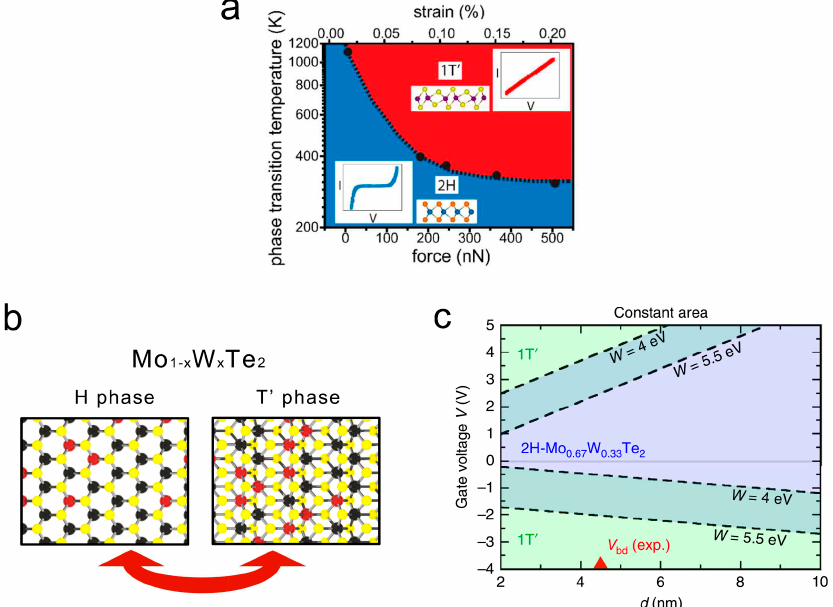
Figure 9. Electron controlled phase transition structure. ( a ) Temperature–force phase diagram for semiconducting 2H and metallic 1T’ MoTe 2 . Reproduced from [107], with the permission of the American Chemical Society. ( b ) Phase structure of WTe 2 . Under the doping of Mo atom, WTe 2 changed from the H phase to T’phase. Reproduced from [115], with the permission of the American Chemical Society. ( c ) Phase boundary at a constant charge in monolayer MoTe 2 and MoS 2 . Reproduced from [112], with the permission of the Springer Nature.